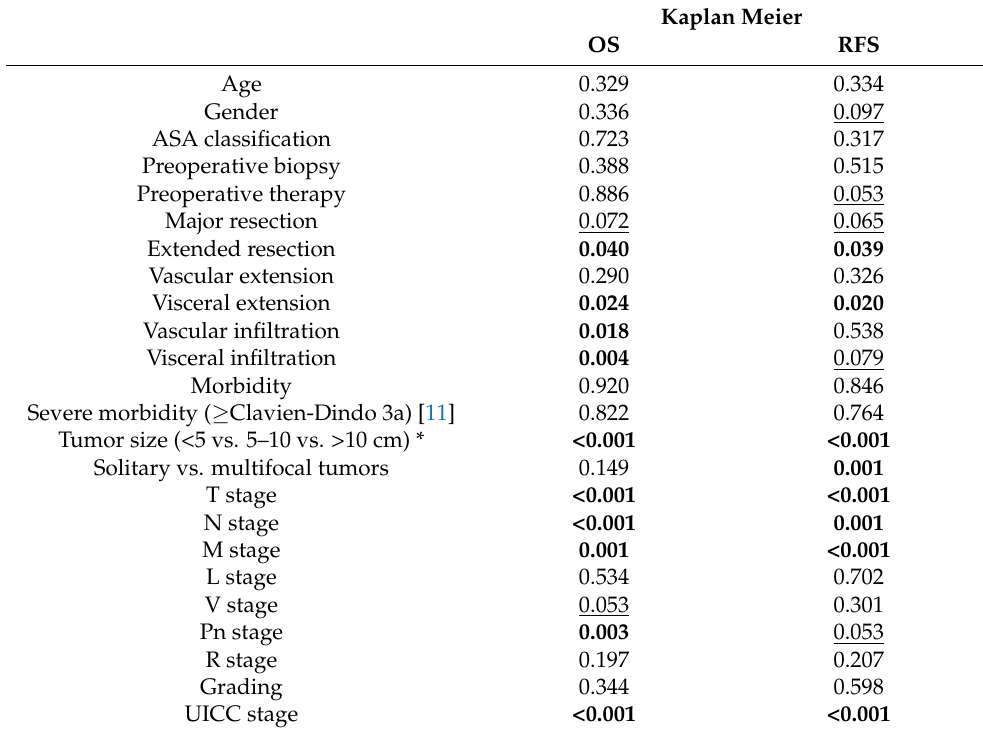
Table 6. Univariate survival analysis.